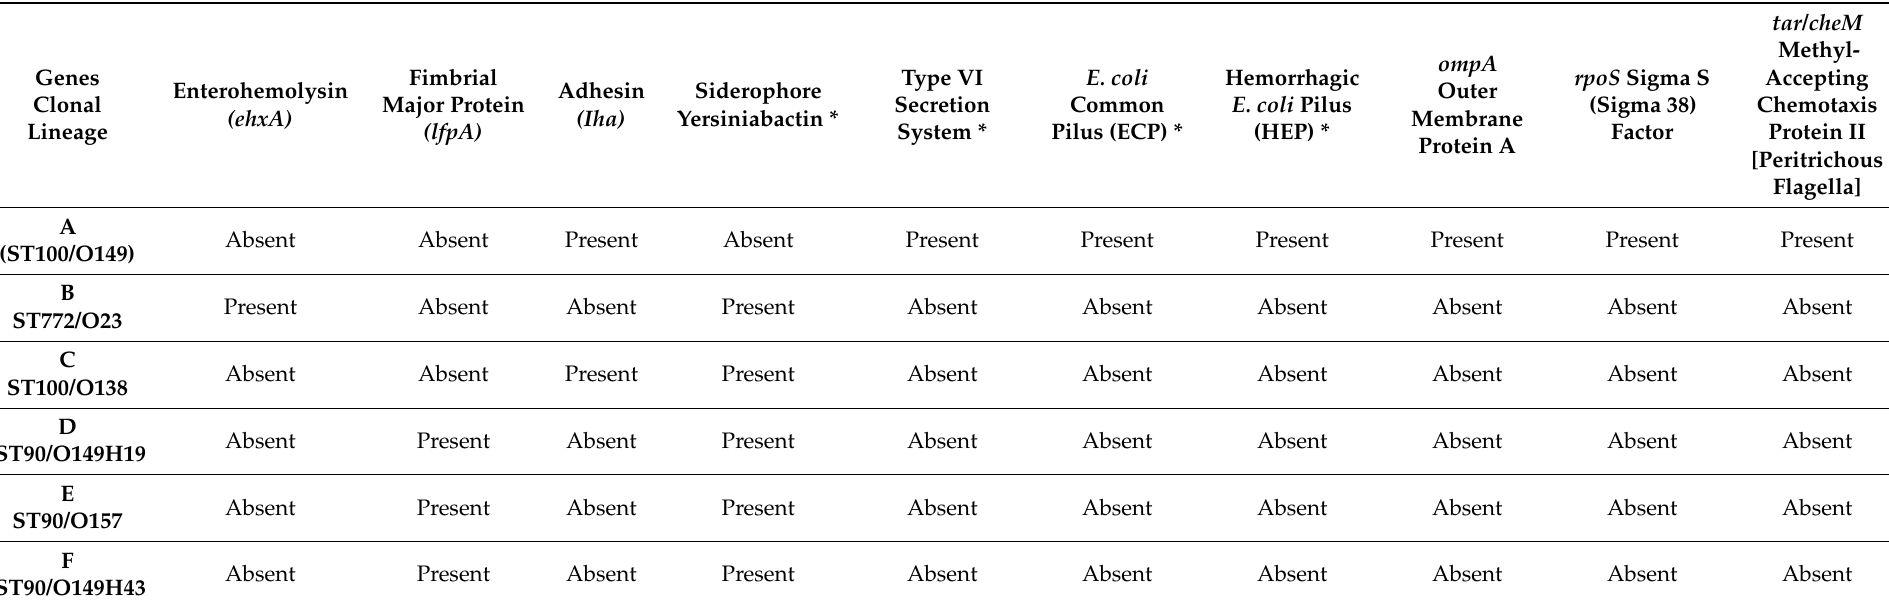
Table 2. Virulence genes specific of the different clonal lineage (the details are available in Tables S2 and S3) * See Table S1 for the complete list of genes.